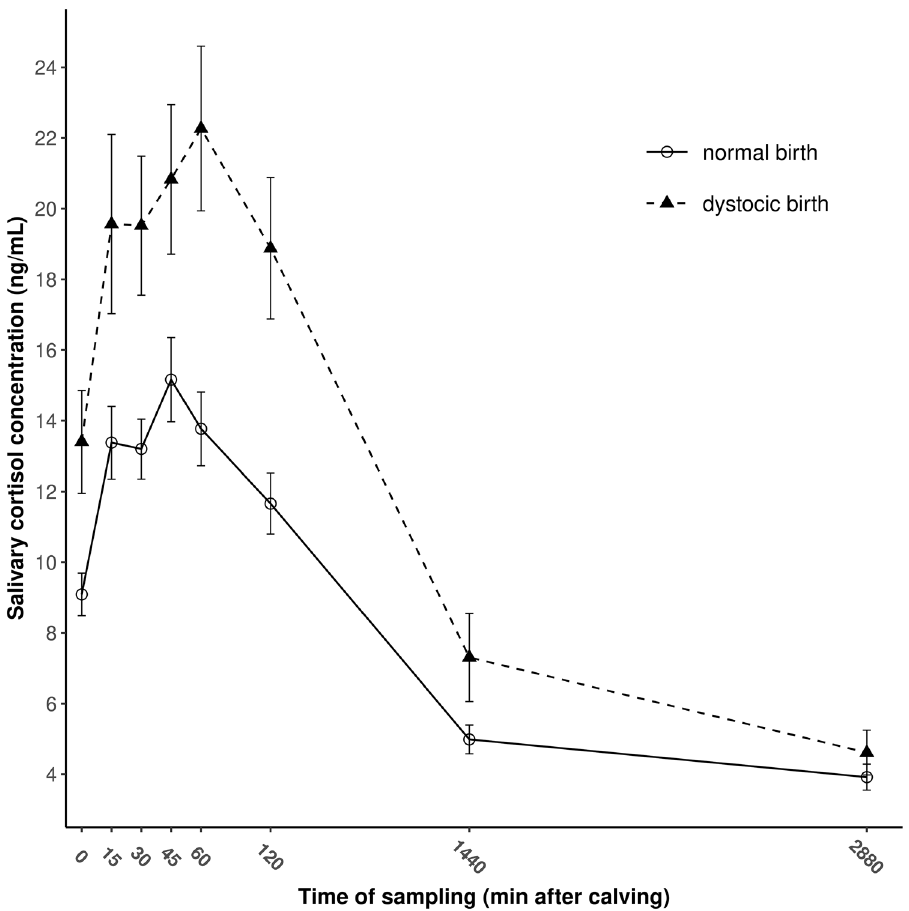
Figure 1. The evolution of salivary cortisol concentrations during the first 48 h of life in dairy calves born to eutocic (n = 98) and dystocic (n = 70) dams. Data are given in means ± SEM.